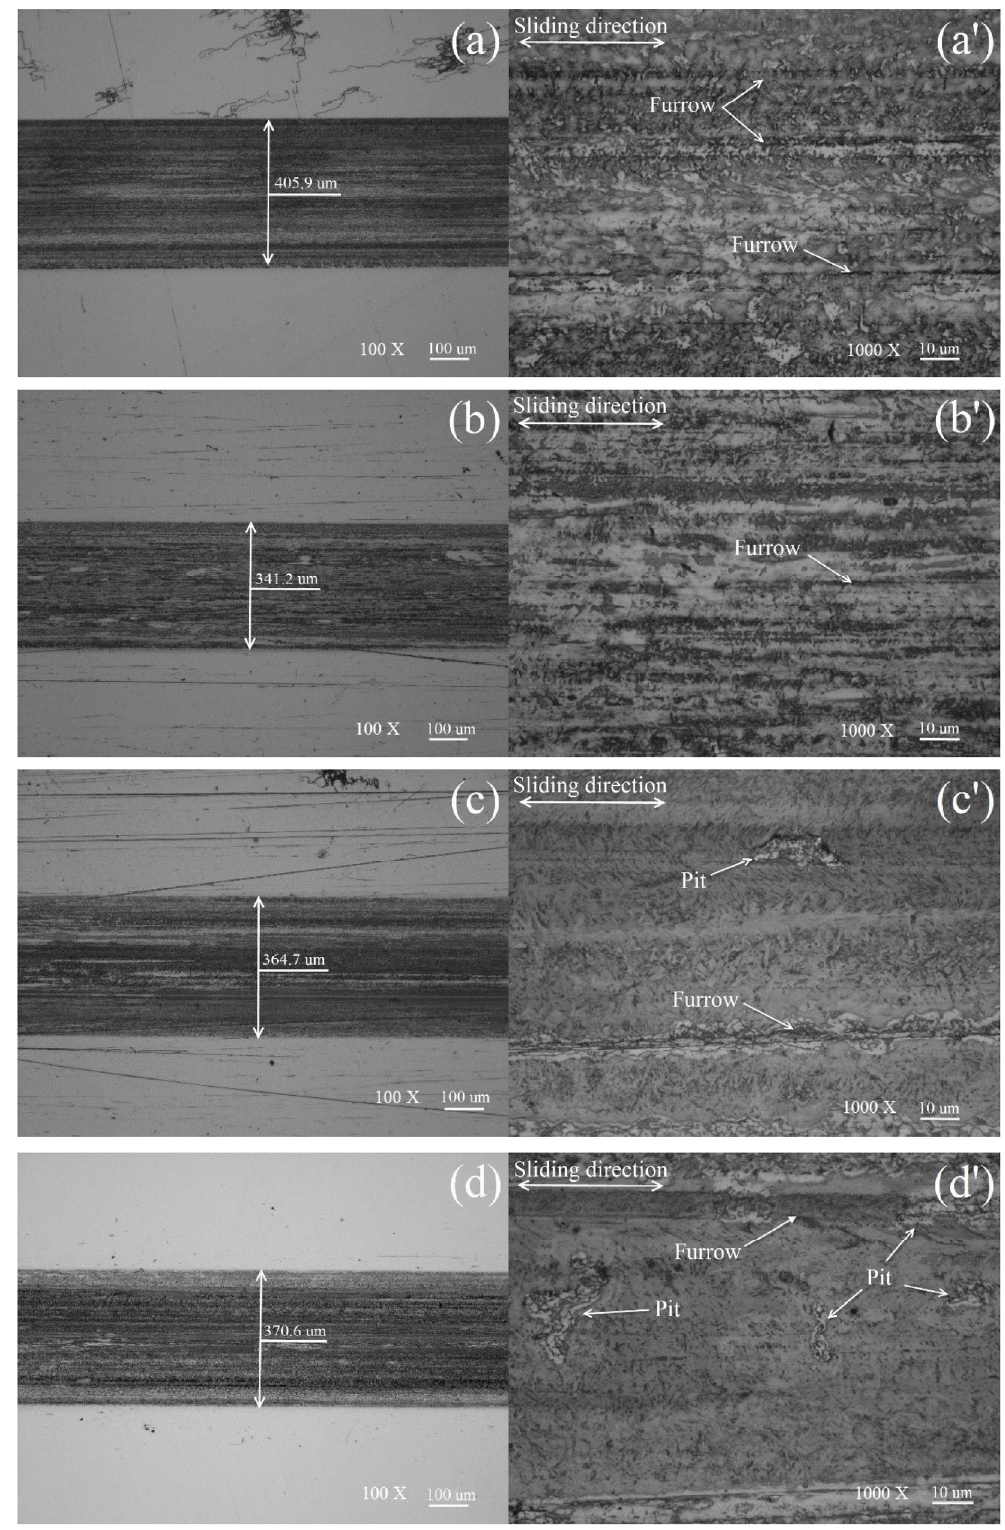
Fig. 8 Morphologies of the worn surfaces lubricated with insulating greases at 200 N, 5 Hz, and RT. (a) and (a') OMMT grease, (b)